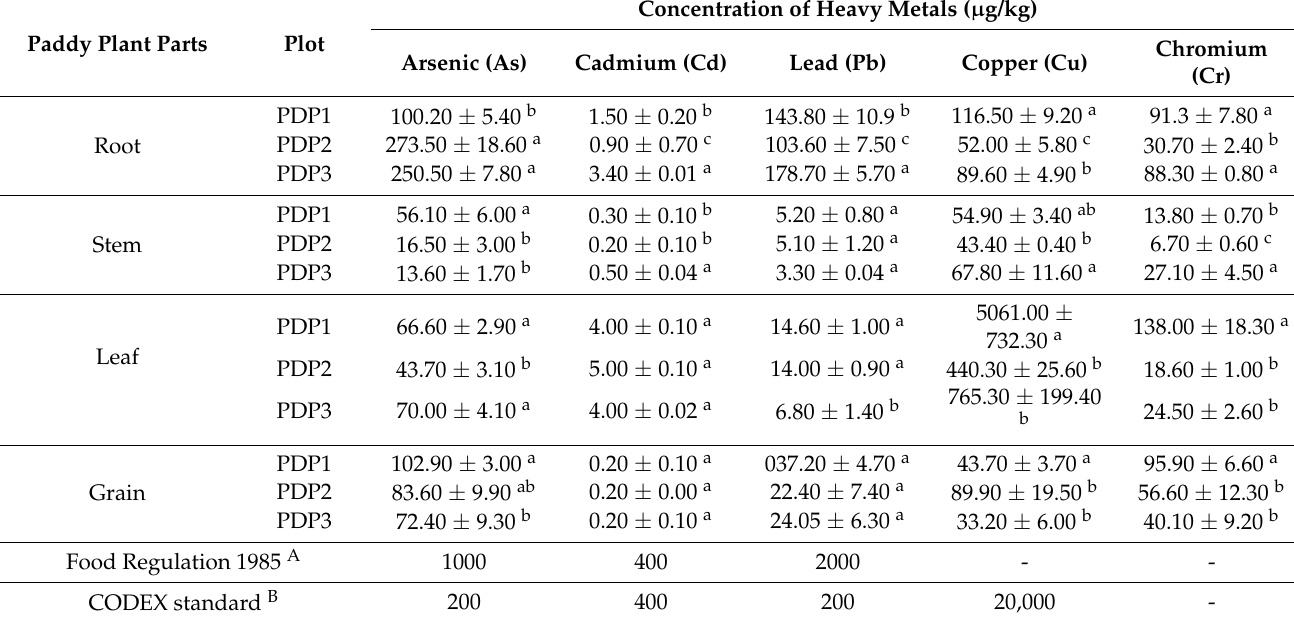
Table 4. Concentration of heavy metals in paddy plant parts from the Pendang